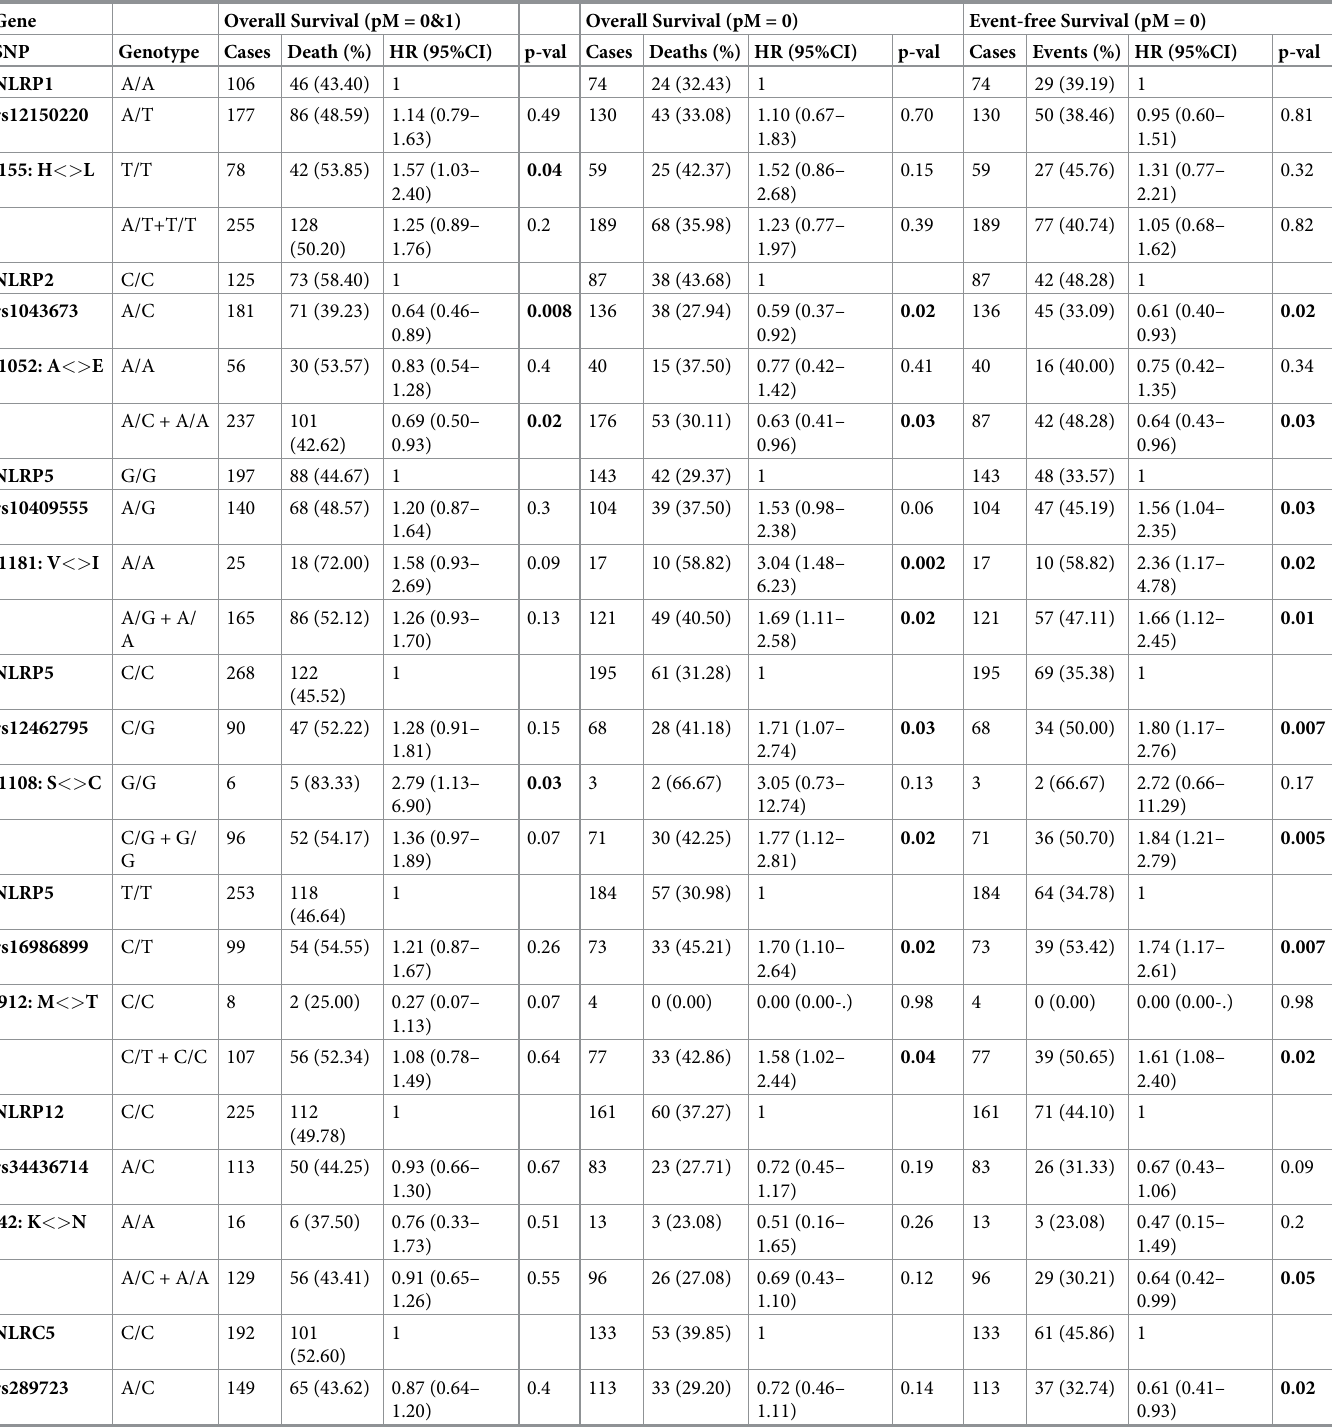
Table 2. Overall survival pM0&1 and pM0, and event-free survival pM0: genotype distribution of SNPs analyzed in the Czech case-control population for SNPs with p (cid:20) 0.05. Amino acid changes are given as <> with the amino acid position indicated. Data adjusted for age at diagnosis and sex, tumor grade and tumor